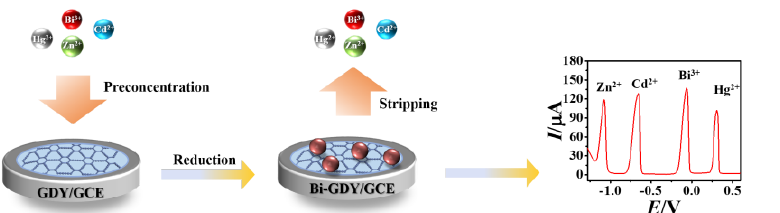
Figure 1. The preparation procedure of Bi–GDY/GCE and the application for simultaneous DPASV detection of Zn 2+ , Cd 2+ and Hg 2+ with co-deposition of Bi 3+ .